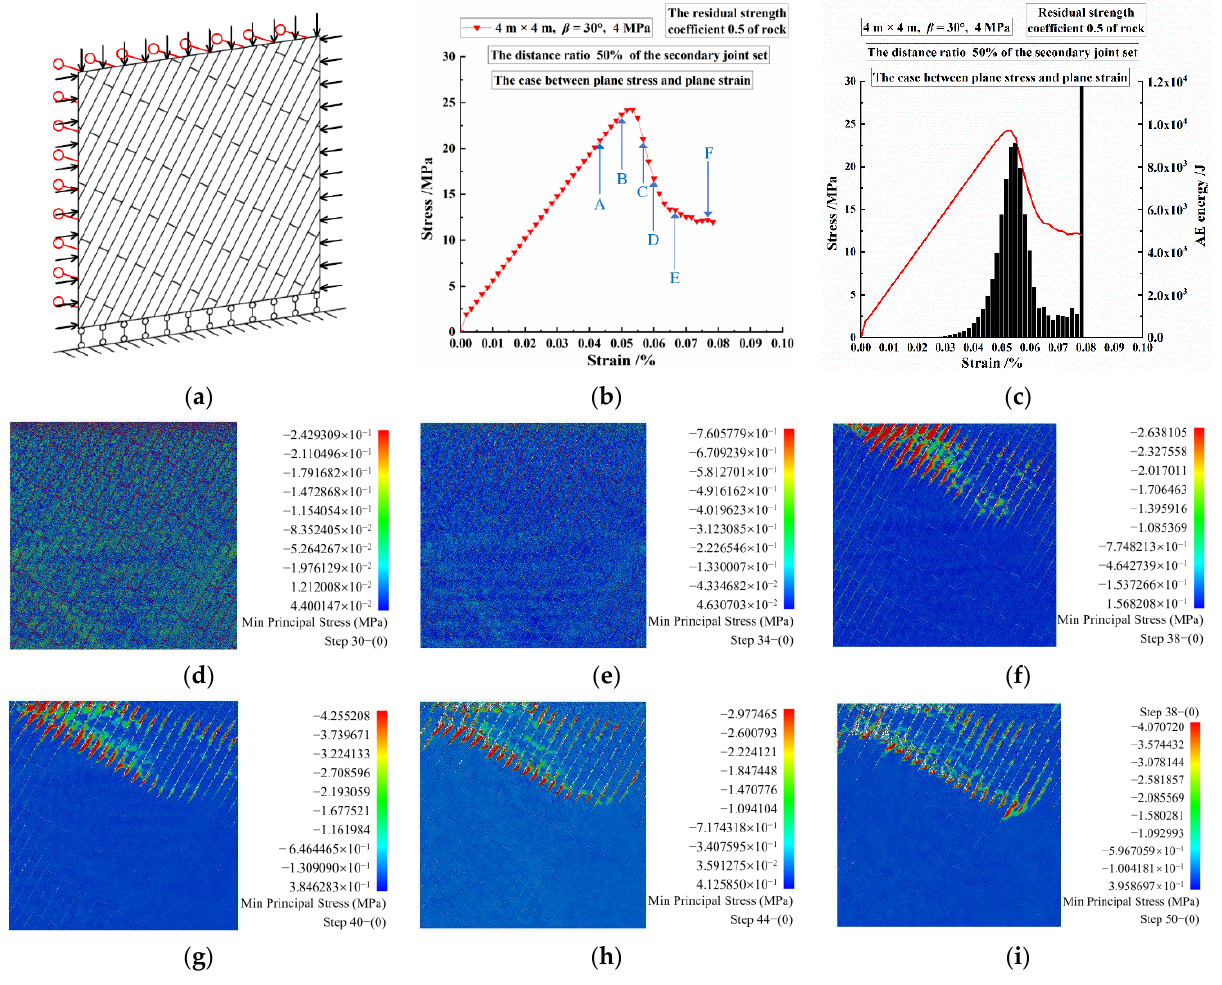
Figure 10. ( a ) For the case between plane stress and plane strain, the schematic diagram of the CJBs model with β = 30° and the joint distance ratio 50%; ( b , c ) the loading curve and AE energy; ( d – i ) the minor principal stress contours at the Points A~F. minor principal stress contours at the Points